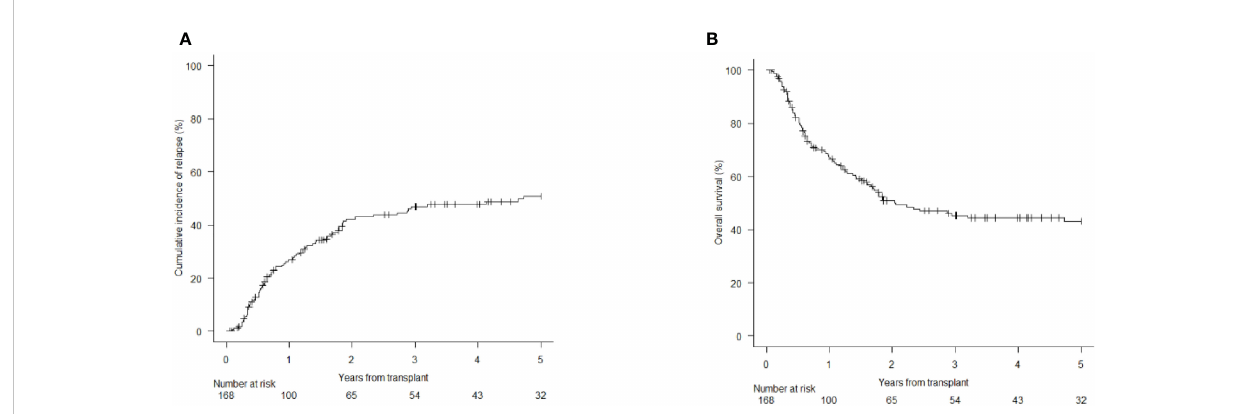
FIGURE 1 Cumulative Incidence of Relapse (CIR) and Overall Survival (OS) of the 168 AML patients included in this analysis. [CIR at 1, 3 and 5 years; 26.9% (95% CI 20.3-34.0), 46.8% (95% CI 38.6-54.4) and 50.8% (95% CI 42.2-58.9) (A) ; OS at 1, 3 and 5 years: 67.3% (95% CI 59.4-74), 50.9% (95% CI 42.6-58.6) and 43.2% (95% CI 34.8-51.3) (B)